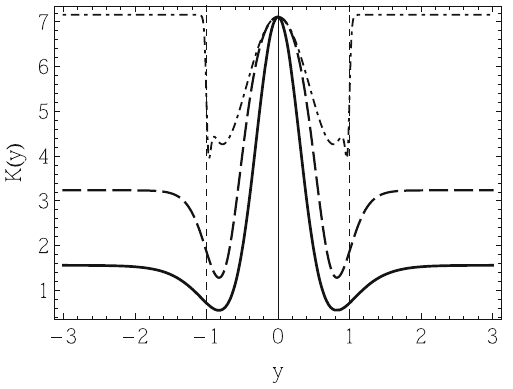
Fig. 8 Kretschmann scalar plotted for n as in Fig. 6